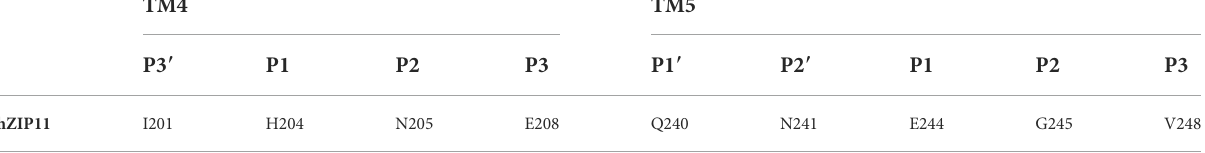
TABLE 7 Subgroup GufA TM4 and TM5 BMC